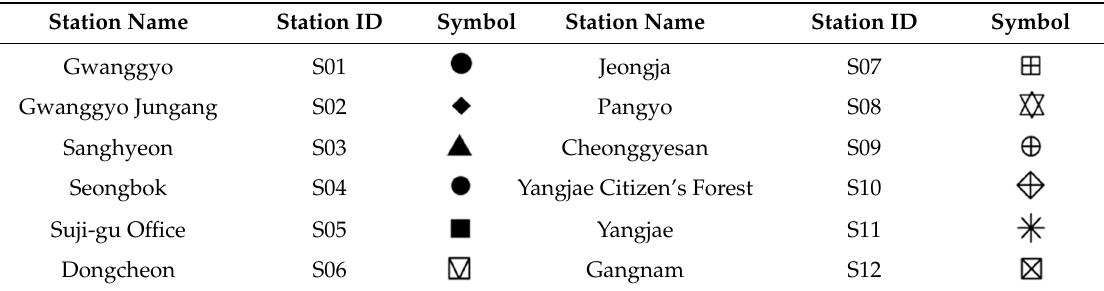
Table 1. Symbols of each station.